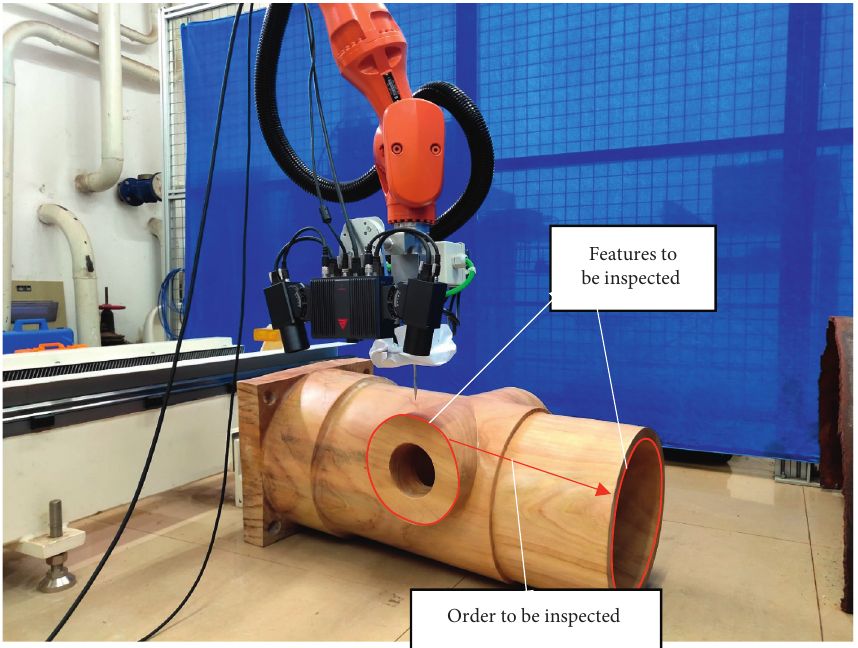
Figure 15: Multifeature detection path